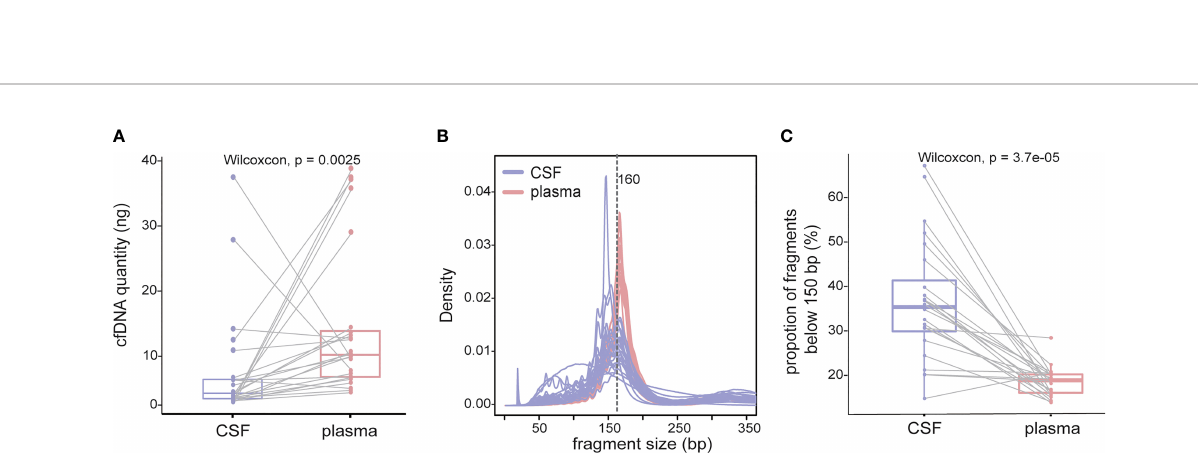
FIGURE 1 | High fraction of ctDNA in CSF. (A – C) Targeted sequencing was performed in matched CSF cfDNA and plasma cfDNA, as described in the Materials and Methods , and the status of driver mutations was compared in CSF and plasma samples. (A) Rates of driver mutation detection in CSF cfDNA and plasma (PLA) cfDNA. (B) The association of driver gene mutation detection in PLA cfDNA with extracranial tumor status. The column on the left represents the disease status when driver mutations were not detected and the majority of patients were shown at stable/regression stages. The column on the right represents the disease status when driver mutations were detected and almost 50% of patients were at the progressive stage. (C) Variant allele fractions (VAFs) of driver mutations in matched CSF cfDNA or PLA cfDNA samples.